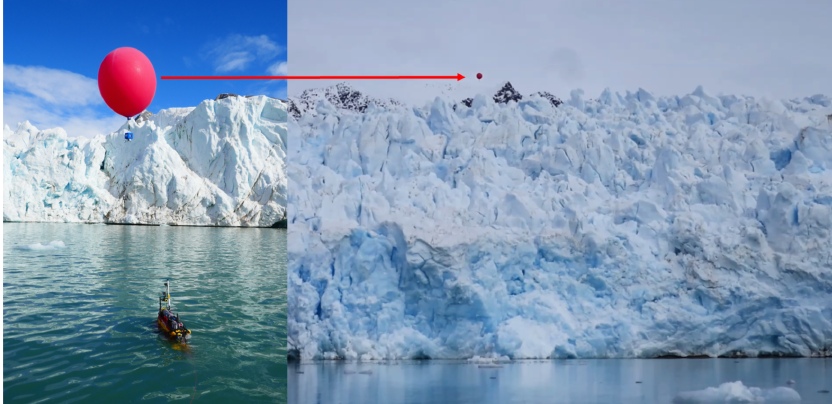
Figure 29. On the left, PROTEUS with the aerostat starting a mission. One the right, PROTEUS measuring in the direct front of the